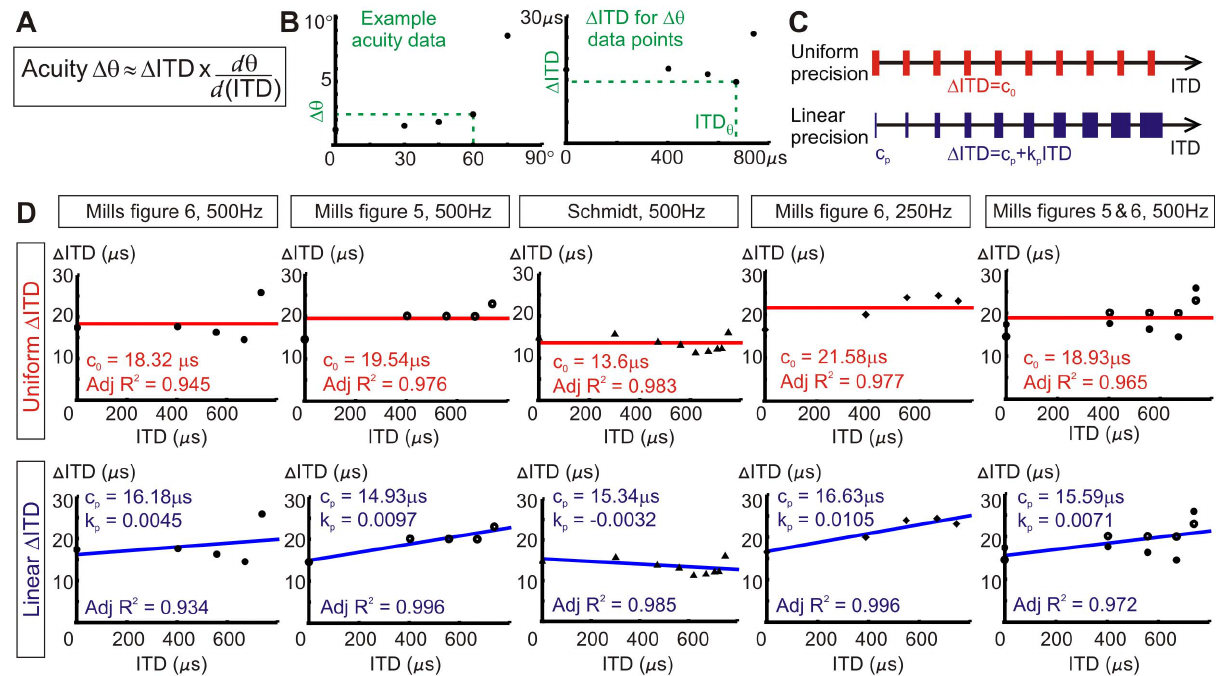
Figure 3. Predicted values of D ITD determined from acuity data. A , Relationship between localization acuity ( Dh ), just-noticeable difference in ITD identification ( D ITD) and the angular variation of ITD. B , Example of how D ITDs are determined for each individual data point in an acuity data set. C , Candidate models for D ITD distributions across ITD. Uniform distributions are described by parameter c 0 and linear distributions are described by parameters c p and k p . D , Best-fit uniform or linear distributions for each acuity data set under consideration. Overall goodness of fit is similar for both distributions. Midline predictions of D ITD are better for the linear distribution, but the proportionality constant is low in all cases and negative in one case (Schmidt data), making them close to the uniform case.